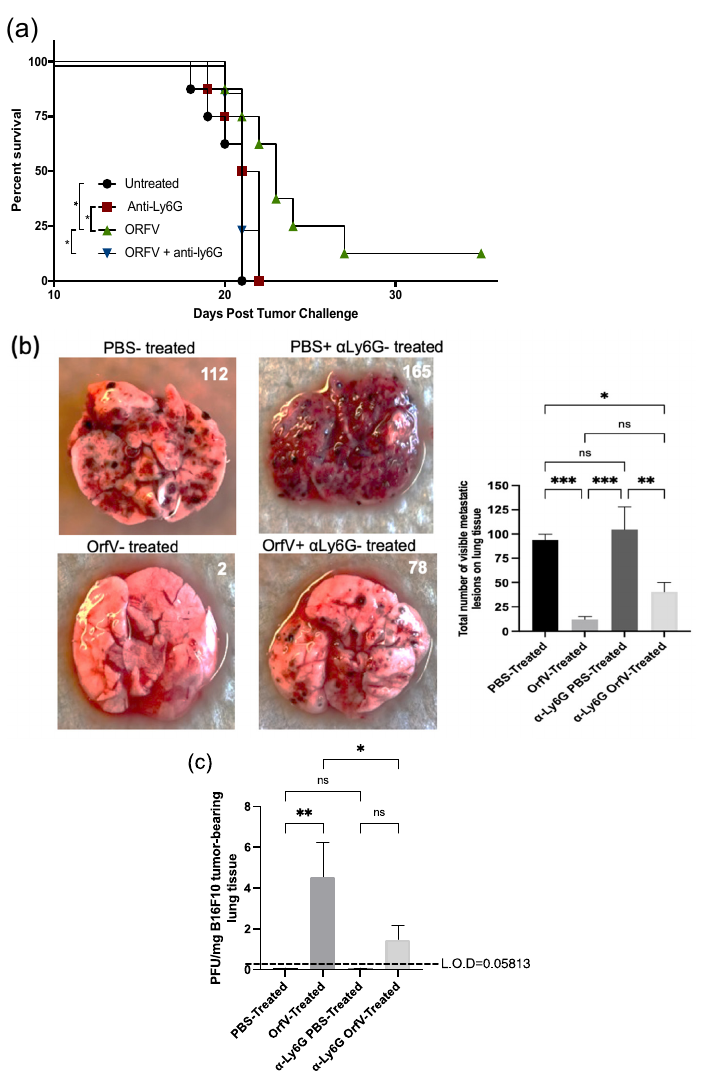
Figure 4. Depletion of neutrophils abrogated the extension of survival and influenced tumor burden and viral replication in the tumor microenvironment following Orf virus (OrfV)-mediated oncolytic virotherapy. Eight-week-old female C57BL/6 mice bearing B16F10 lung metastases ( n = 8 per group) were treated with Ly6G-specific antibodies to deplete neutrophils. Controls did not have neutrophils depleted. Mice were then treated with PBS or 5 × 10 7 PFU of OrfV via intravenous injections four days post-tumor challenge: ( a ) survival was assessed by a log-rank test; ( b ) fourteen days post-tumor challenge, lungs were excised, and the number of surface metastases was counted. Representative images of lungs from each group of mice are shown, and data are represented as a bar graph with standard errors; ( c ) twenty-four hours following administration of OrfV, lung tissues were excised, and replication-competent virions were enumerated using a tissue culture of 50% infective dose assay. The amount of input virus was subtracted from the results for all mice to show how much replication had occurred in vivo. Statistical analysis was performed using one-way analysis of variance. Statistical significance was designated as * p ≤ 0.05, ** p ≤ 0.01, *** p ≤ 0.001.